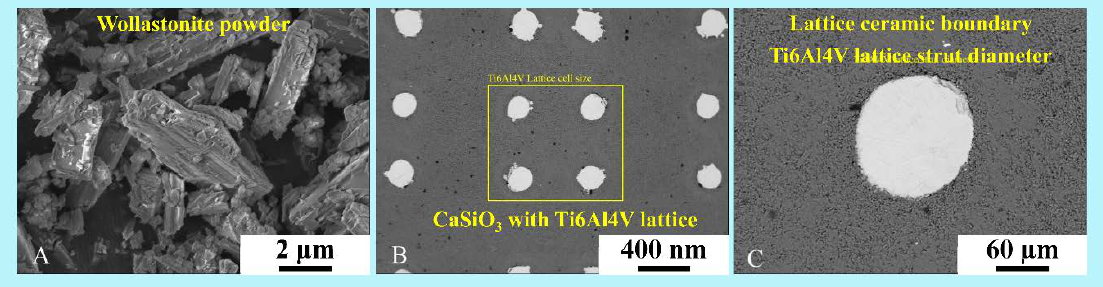
Figure 9 . SEM micrographs of ( A ) wollastonite (CaSiO3) powder, ( B ) Sintered CaSiO 3 embedded in a Ti6Al4V lattice after SPS, and ( C ) High magnification image of metal-ceramic boundary.